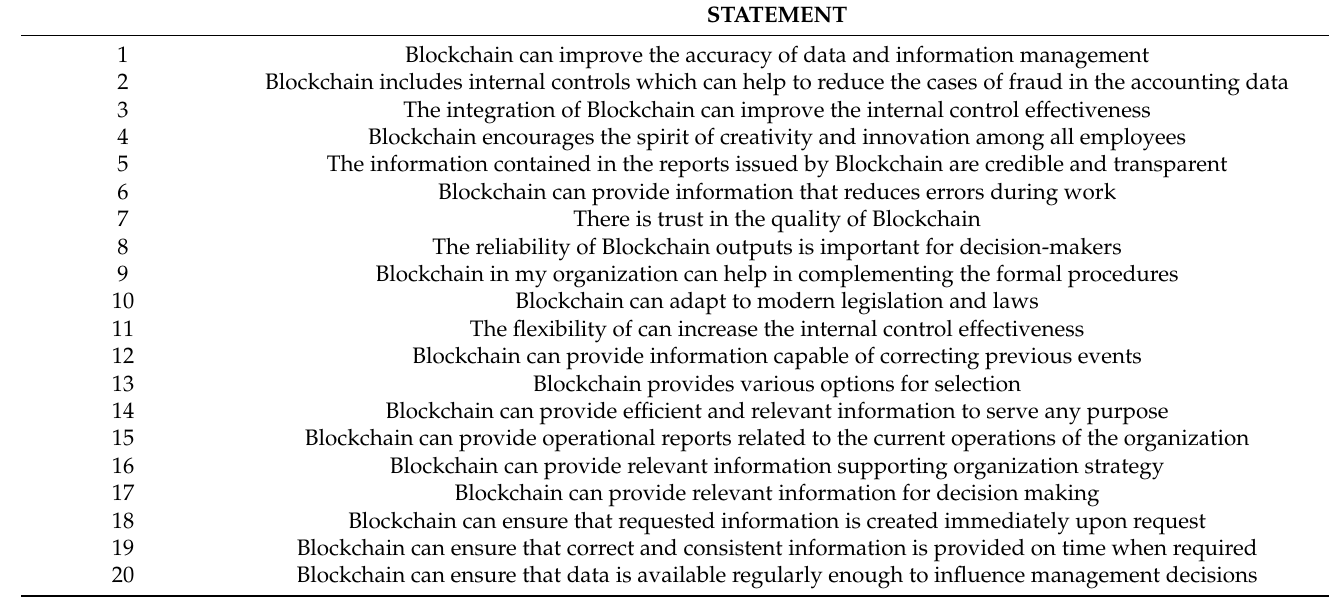
Table 2. List of statements on the perceived effectiveness model (Source: authors’ compilation).